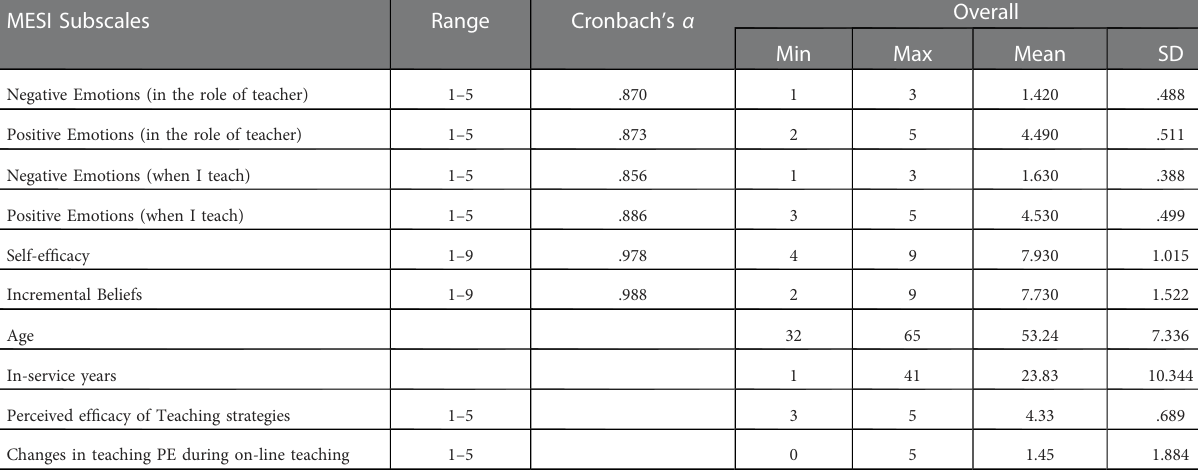
TABLE 1 Descriptive statistics and Cronbach ’ s alphas of the subscales (overall sample n =104).